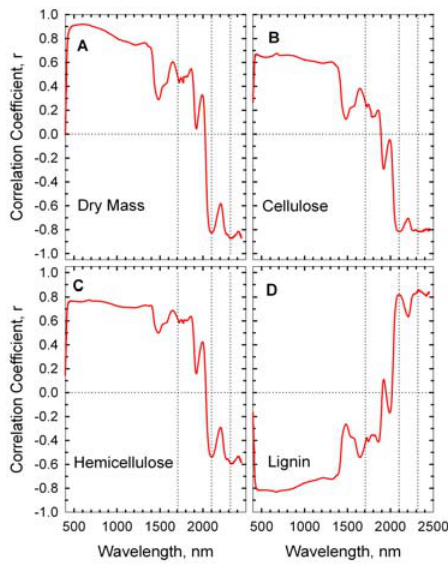
Figure 5. Correlograms of wheat straw components and reflectance spectra. Dotted vertical lines are at 1,710, 2,100, and 2,310